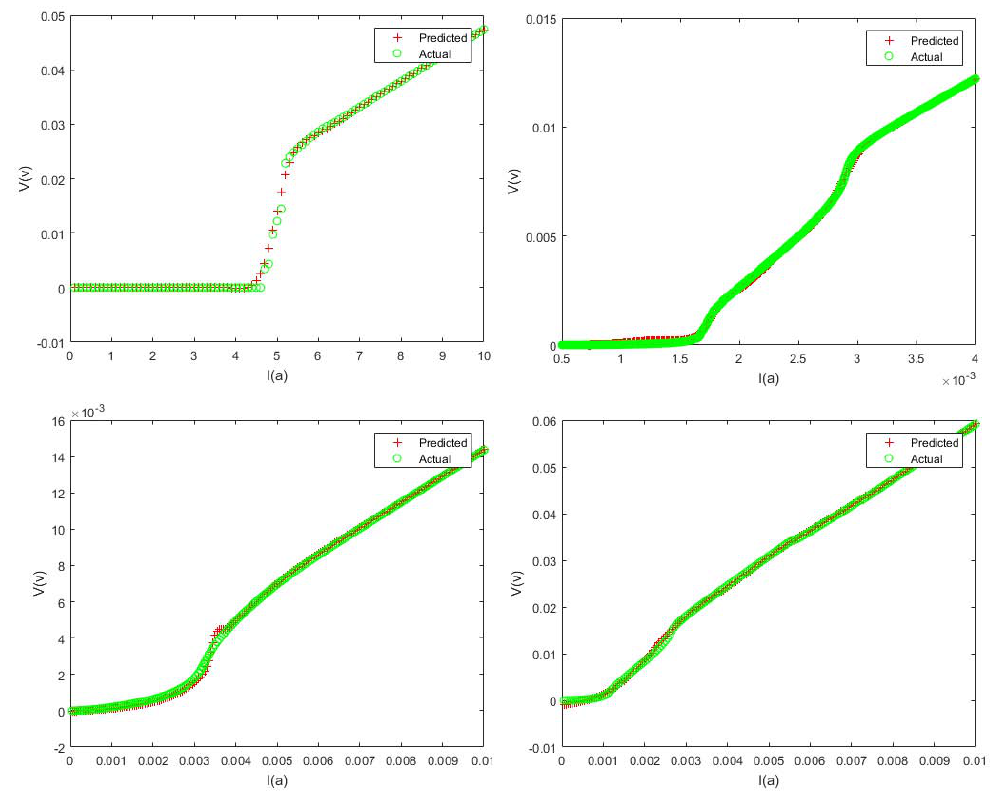
Figure 6. Predicted vs. measured IV